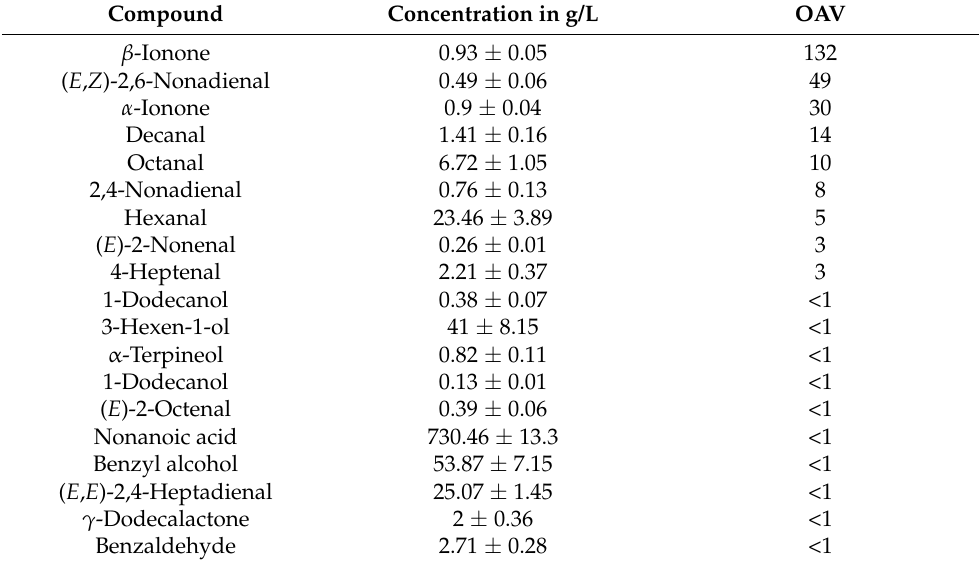
Table A7. Results of semi-quantification and calculated OAVs for sample 687.